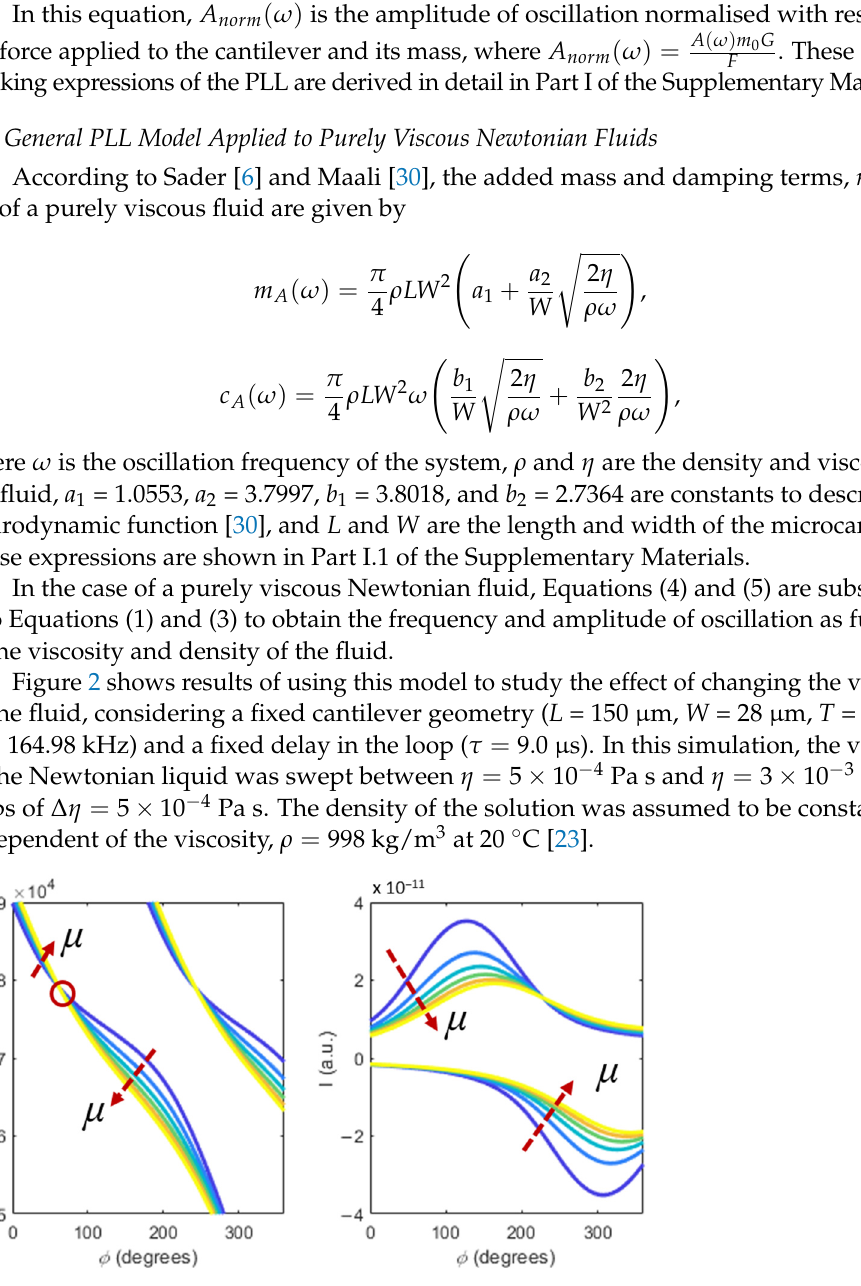
Figure 2. Frequencies of oscillation ( left ) and quadrature component of deflection I ( right ), as function of the imposed phase φ in the PLL and the viscosity of a Newtonian fluid. Two branches are observed for n = 2 ( left branch ) and n = 3 ( right branch ). Viscosity values range between η = 5 × 10 − 4 Pa s and η = 3 × 10 − 3 Pa s, in steps of ∆ η = 5 × 10 − 4 Pa